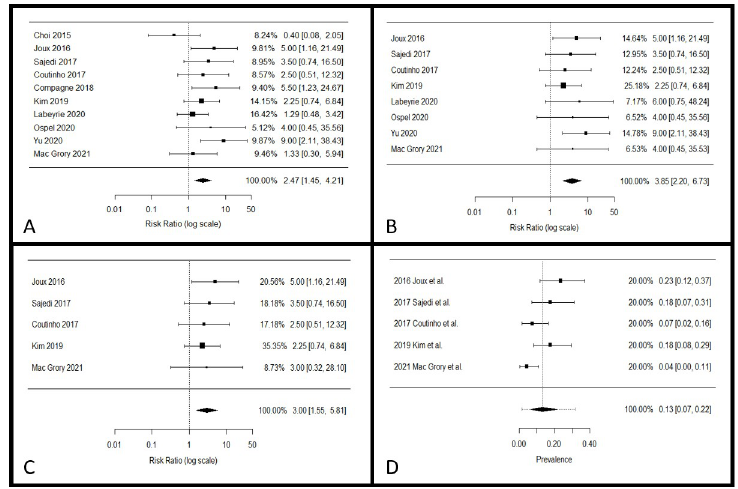
Fig 2. Meta-analysis of carotid web in ischemic stroke cohorts. Panel A: Relative risk of ipsilateral versus contralateral carotid web in patients with stroke All studies. (I 2 = 27.71%, p = 0.0009). Panel B: Cryptogenic stroke only. (I 2 = 0%, p = 0.0001). Panel C: Cryptogenic stroke in patients less than 60 years old. (I 2 = 0%, p = 0.001). Panel D: Pooled prevalence of ipsilateral carotid web in young ( < 60) patients with cryptogenic stroke combined via a random effects model. (I 2 = 65.42%). Please note that “Mac Grory 2021” refers to the present study. data on patients < 60 with cryptogenic stroke, a total of 332 patients. The other studies con- tained a higher proportion of patients of Black patients than our study (ranging from 54.5% [9] to 100% [8]). The relative risk of carotid web ipsilateral versus contralateral to ischemic stroke was 2.5 (95%: 1.5–4.2, p < 0.01) in all patients with acute ischemic stroke and 3.0 (95% CI: 1.6–5.8, p < 0.01) in patient less than 60 with cryptogenic stroke (Fig 2A–2C). The pooled prevalence of ipsilateral carotid web in patients < 60 with cryptogenic stroke was 13% (95% CI: